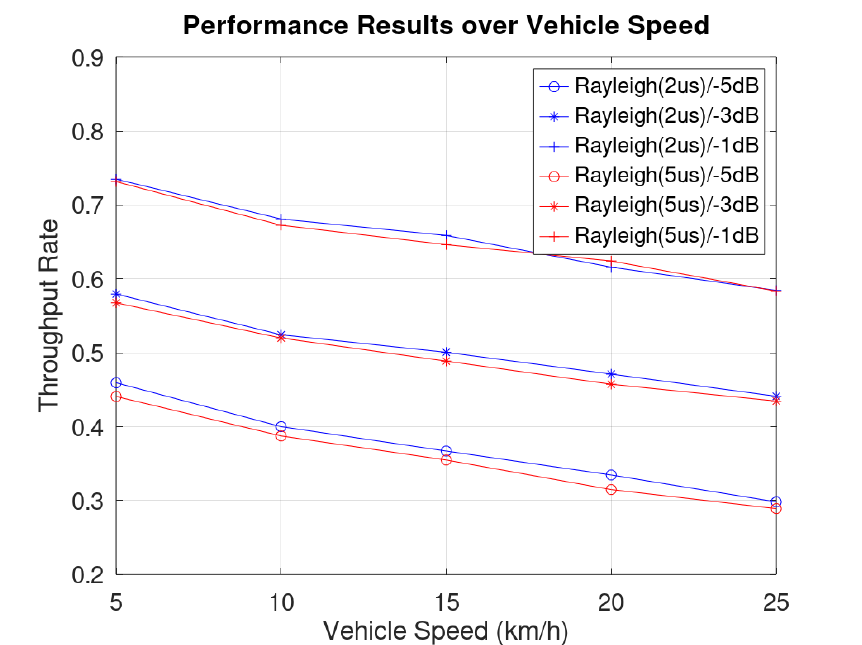
Figure 9. Throughput rate over vehicle speeds in different equal-gain two-paths Rayleigh fading